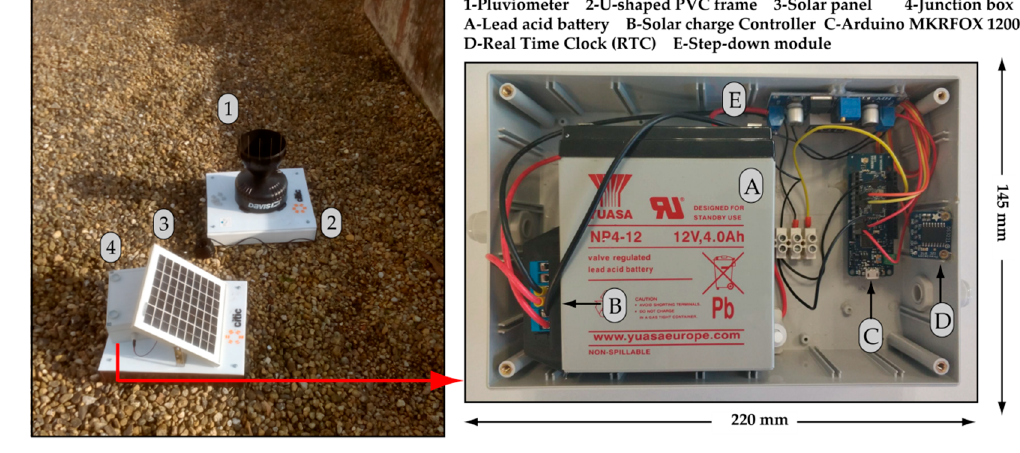
Figure 1. Low-cost rain gauges developed in the TREBOADA observing